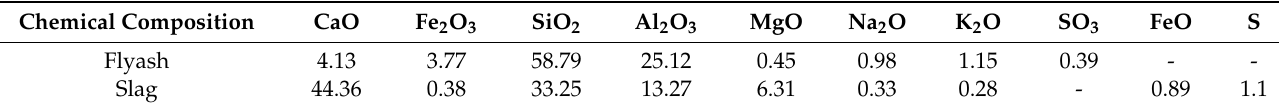
Figure 1. Particle gradation curve of coal gangue. Table 3. Chemical constituents wt/%.